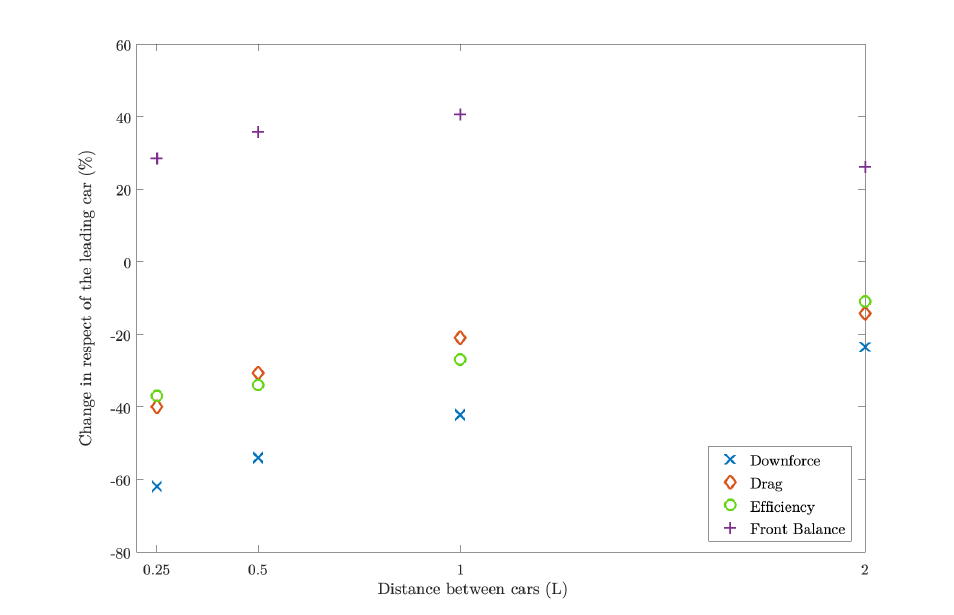
Figure 16. Percentage change of the performance of the second car in respect of the leading